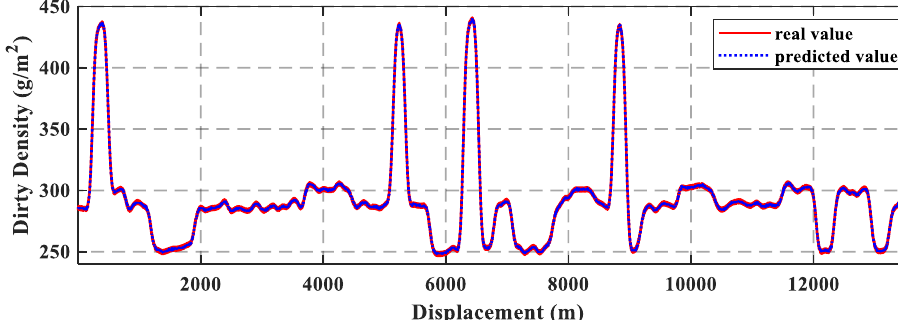
Figure 16. Training verification of the NARNN. Figure 17. Details of training performance of the NARNN.